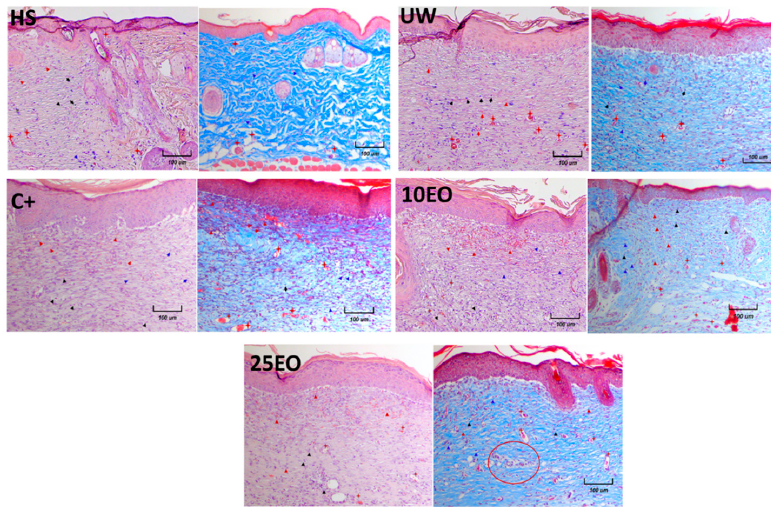
Figure 7. Histology of skin samples from a treated wound on day 10 of treatment. Samples were stained with hematoxylin and eosin (H&E) and Masson’s trichrome. All photos were taken at a 10X magnification. HS, healthy skin. UW, untreated wound. C + , positive control—Recoveron NC. 10EO, 10% essential oil. 25EO, 25% essential oil. ► Erythrocytes, ► basophil cells (positive hematoxylin), ► fibroblast, + blood vessel.